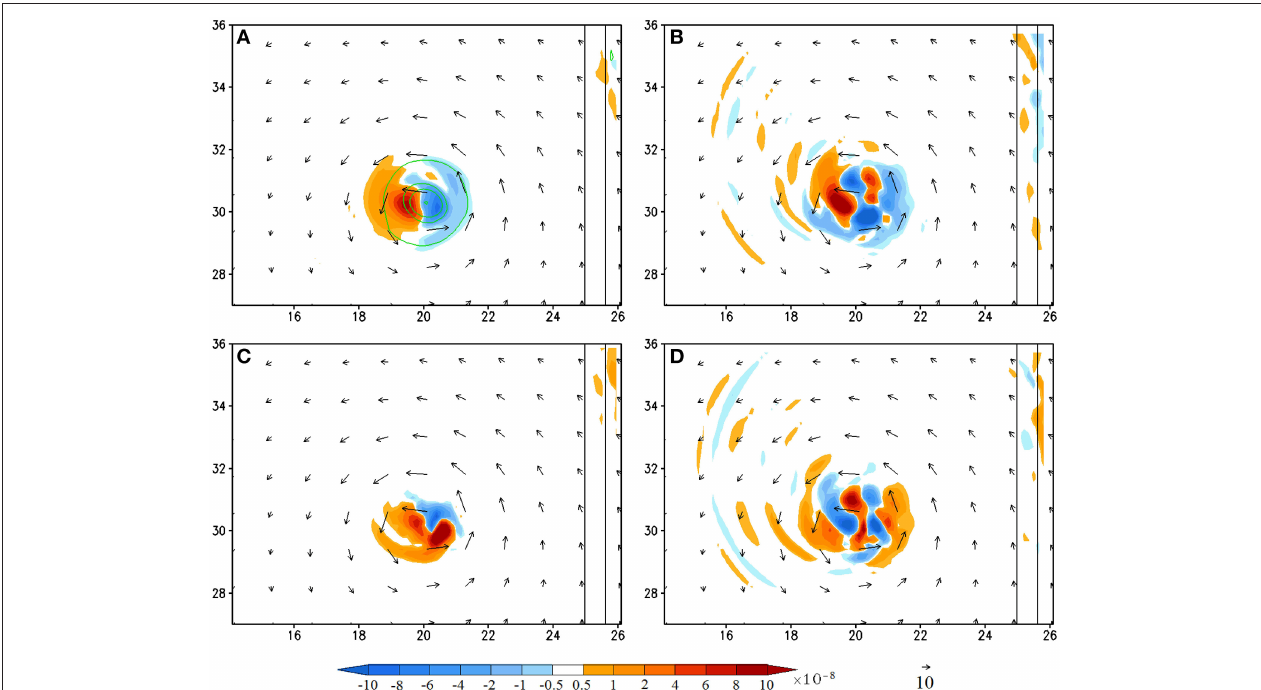
FIGURE 7 | (CNTL/A2) Vorticity budget analysis averaged for the 950–500 hPa layer at 216h (shaded): (A), vorticity tendency (VT); (B), horizontal vorticity advection; (C), relative vorticity stretching, and (D), residual term. The vertical vorticity field is depicted by contours (0.0001, 0.0005, 0.001, 0.002, 0.003 s − 1 ) in (A) . The residual term is obtained by subtracting (A) by the sum of (B,C) , vertical advection, planetary vorticity stretching, and tilting terms. The last three terms are not shown since their magnitudes are negligible compared to terms (A–C) . The units of the coordinates in the x and y directions are 100km.